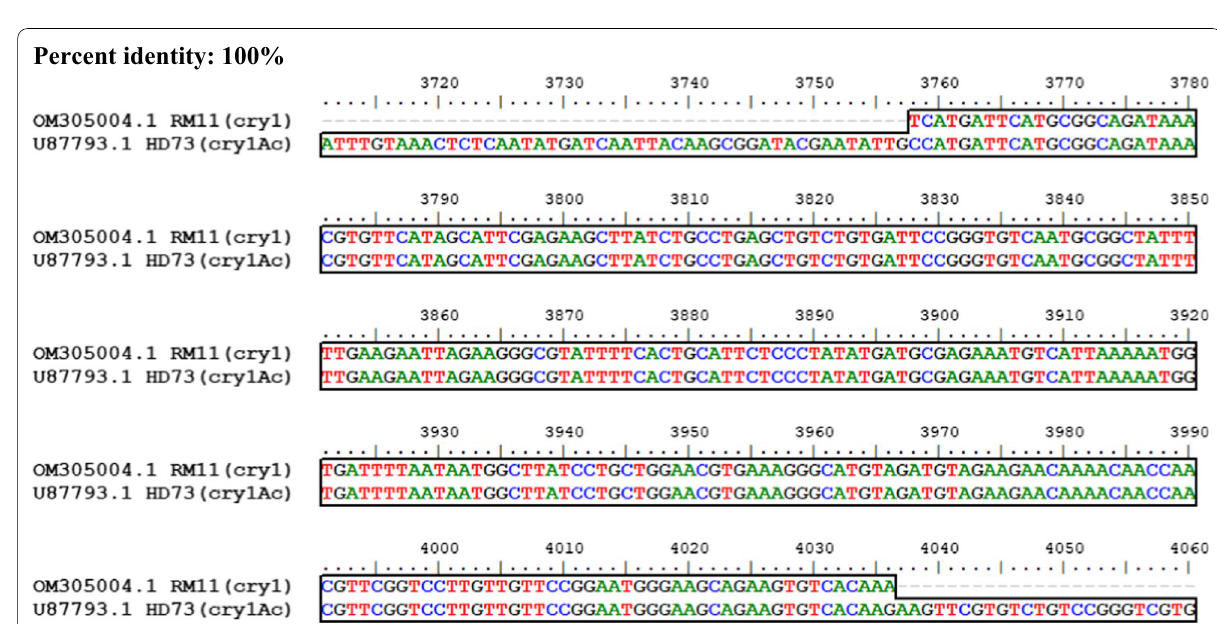
Fig. 5 Alignment of nucleotide sequence of partial cry1 gene amplified from genomic DNA of Bacillus thuringiensis isolate RM11 (GenBank Acc. No.